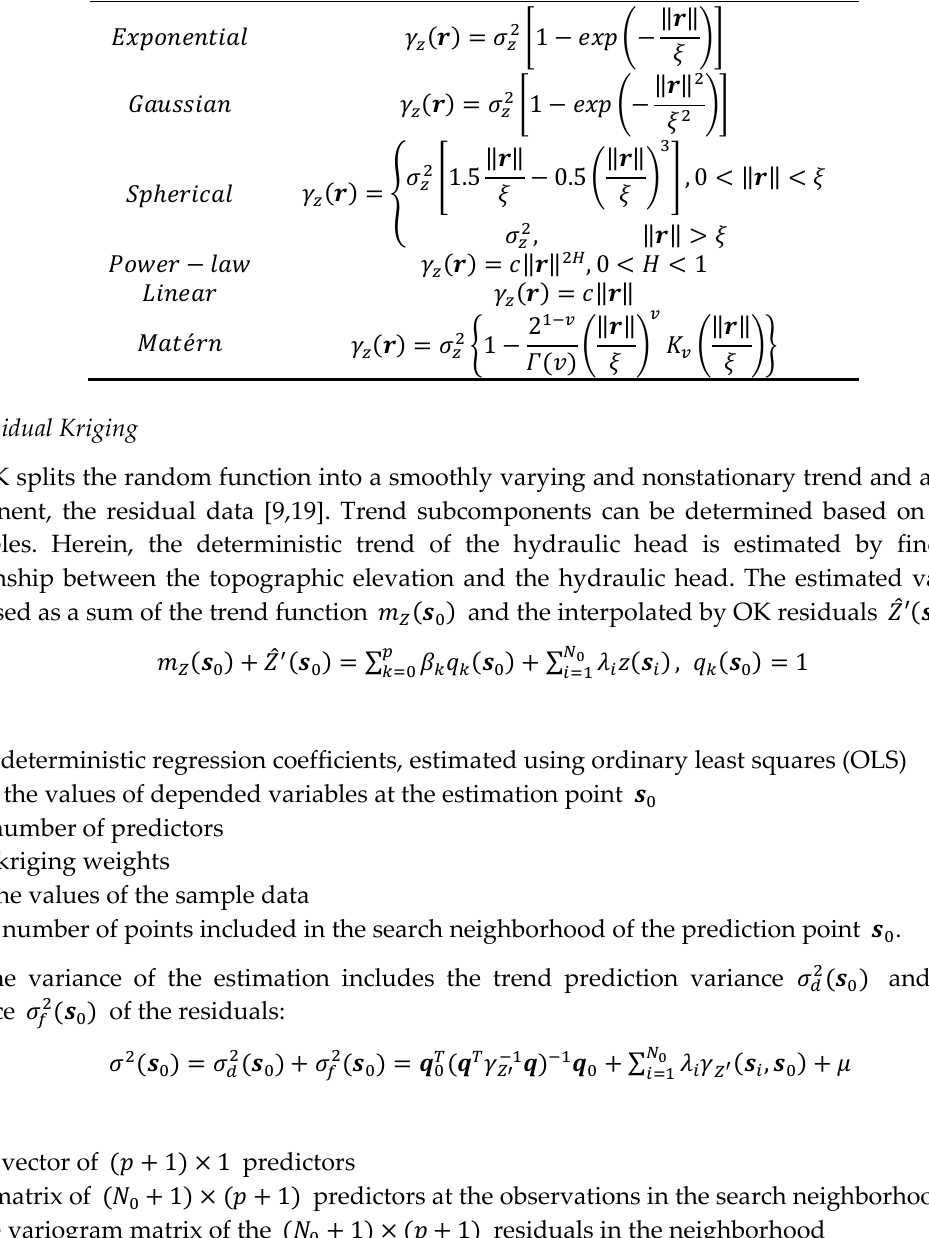
Table 1. Theoretical model functions: (cid:2026) (cid:3053)(cid:2870) is the variance, (cid:2200) is the spatial separator vector, (cid:2022) is the correlation length, (cid:1855) is the coefficient, (cid:1834) is the Hurst exponent, (cid:1874) is the smoothness parameter, (cid:1985)(cid:4666)∙(cid:4667) is the Gamma function and (cid:1837) (cid:3049) (cid:4666)∙(cid:4667) is the modified Bessel function of the second kind of order (cid:1874) [18]. Model